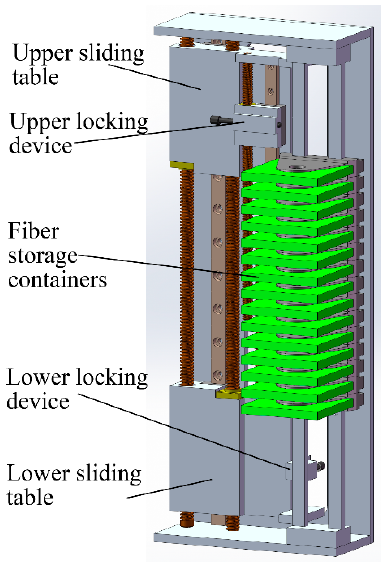
Figure 7. Composition of the shedding mechanism.